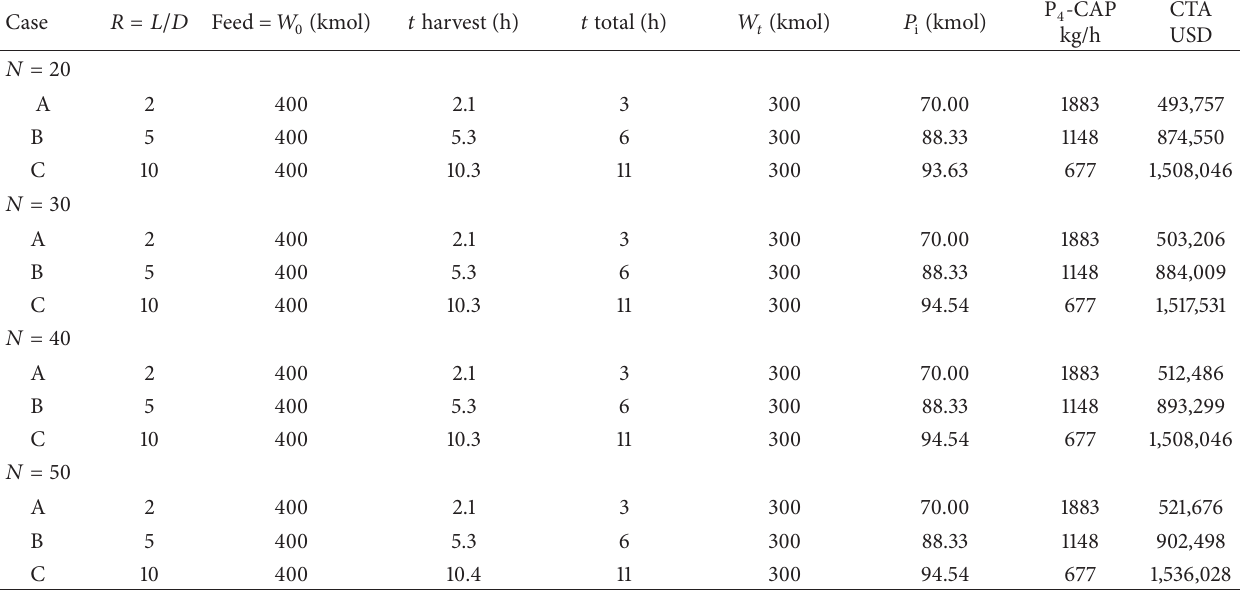
Table 4: Four-component separation: benzene (i), toluene (ii), ethylbenzene (iii), and o-xylene (iv) at constant reflux.